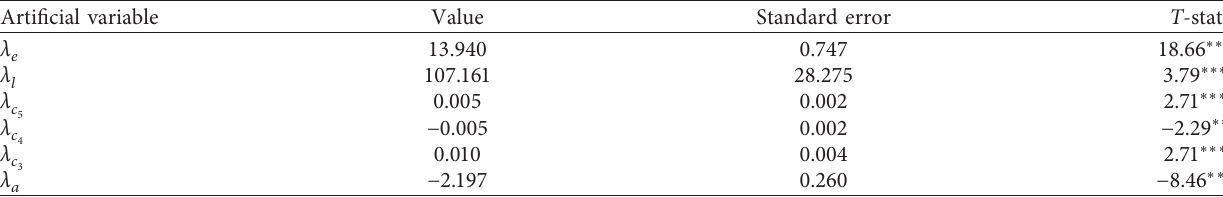
Table 11: Specification test for all the parameters in the departure time choice model.